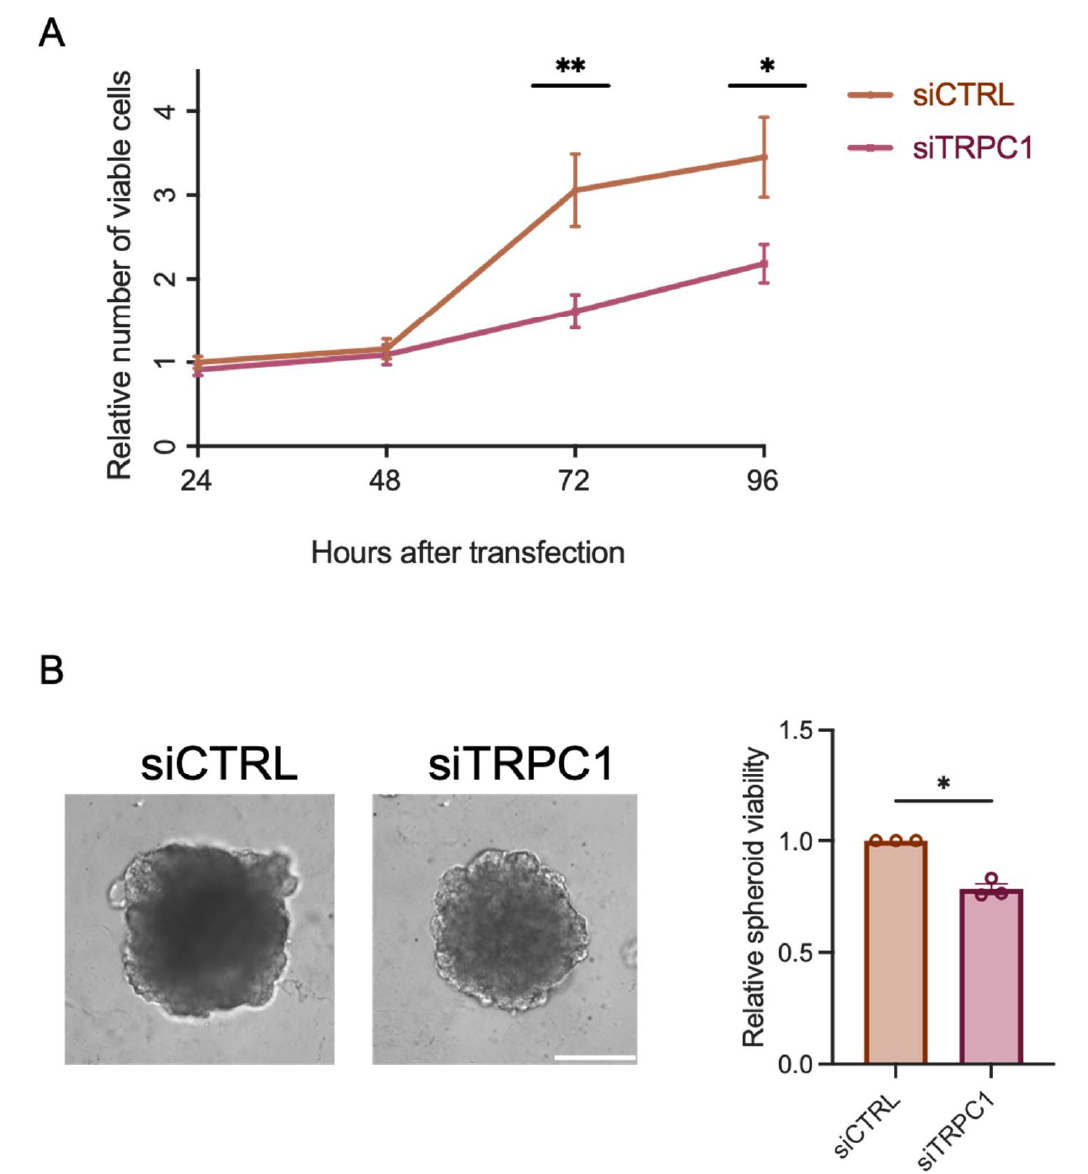
Figure 3. The knockdown of TRPC1 inhibits PANC-1 cell proliferation and spheroid growth. ( A ) try- pan blue analysis of transfected PANC-1 cells shows the relative number of viable cells compared to siCTRL 24, 48, 72, and 96 h post-transfection ( n = 4). ( B ) Representative images of PANC-1 spheroids grown for nine days (left panel) and quantification of CellTiter-Glo ® assay (right panel) ( n = 3), scale bar = 400 µ m. Welch’s correction t-test was used to determine the significant difference between siCTRL and siTRPC1; * and ** indicate p < 0.05 and 0.01,